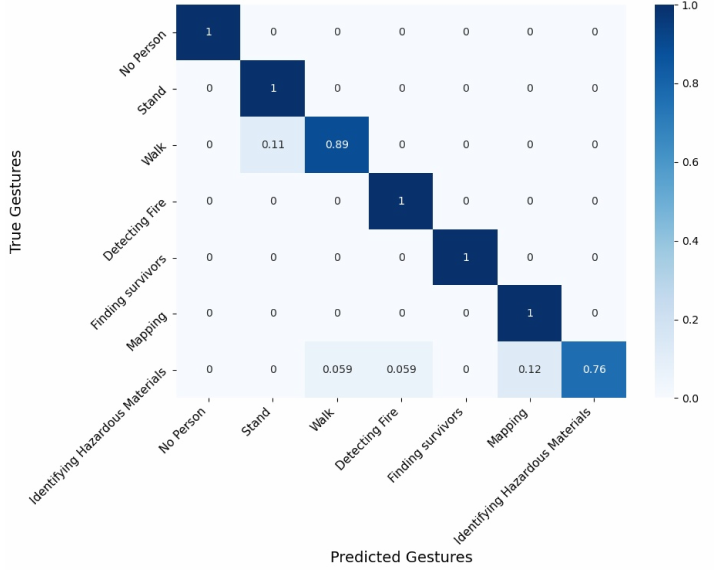
Figure 10. Confusion matrix for the thermal sensor with skeleton extraction + SVM, without smoke, and without